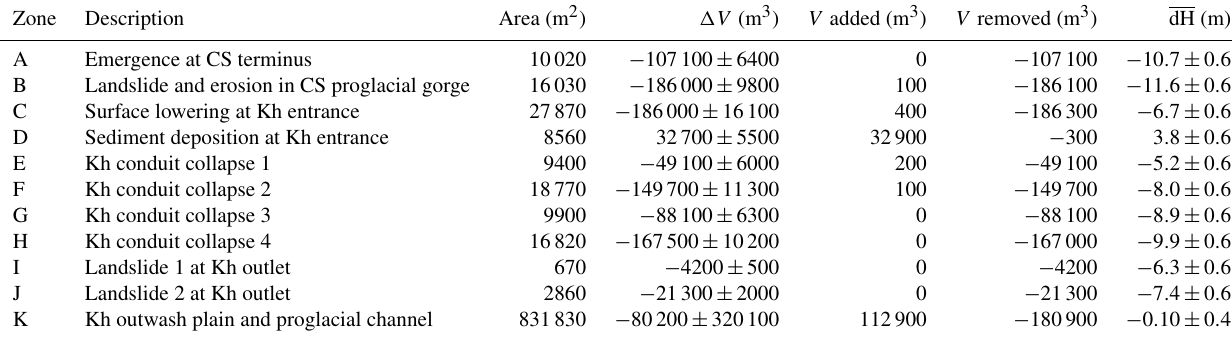
Table 1. Measured elevation changes associated with the lake drainage and outburst within key zones identified with the Pléiades stereo- imagery. CS and Kh denote Changri Shar and Khumbu glaciers, respectively. Zones are identified in Fig. 2. (cid:49)V expresses the total volumetric change in each zone, and the full uncertainty based on σ dH for the zone area. “ V added” and “ V removed” are based on the elevation changes exceeding σ dH . dH is the mean change in elevation within the zone, with uncertainty σ dH